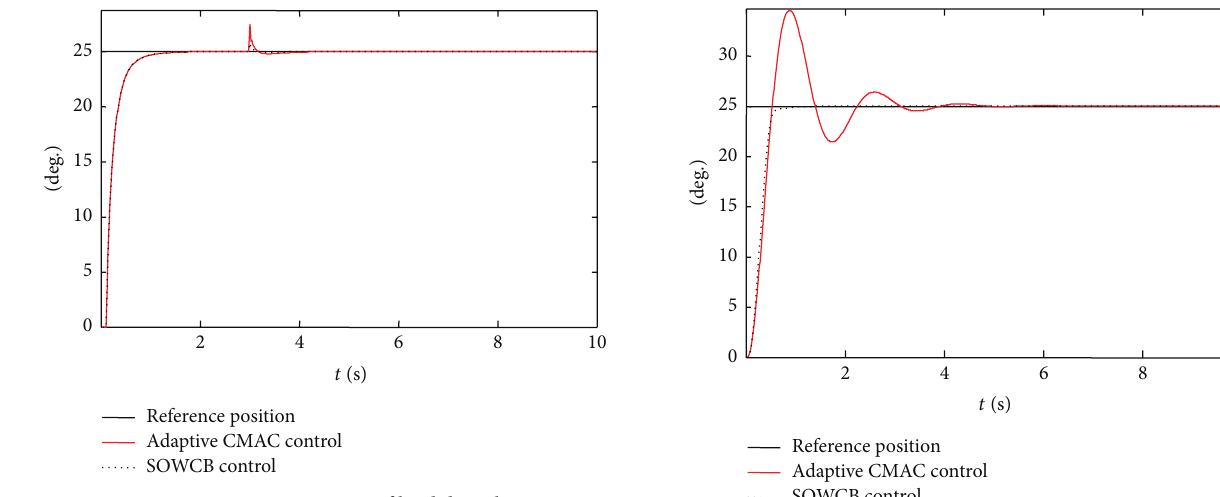
Figure 4: Step response curve of load disturbance.